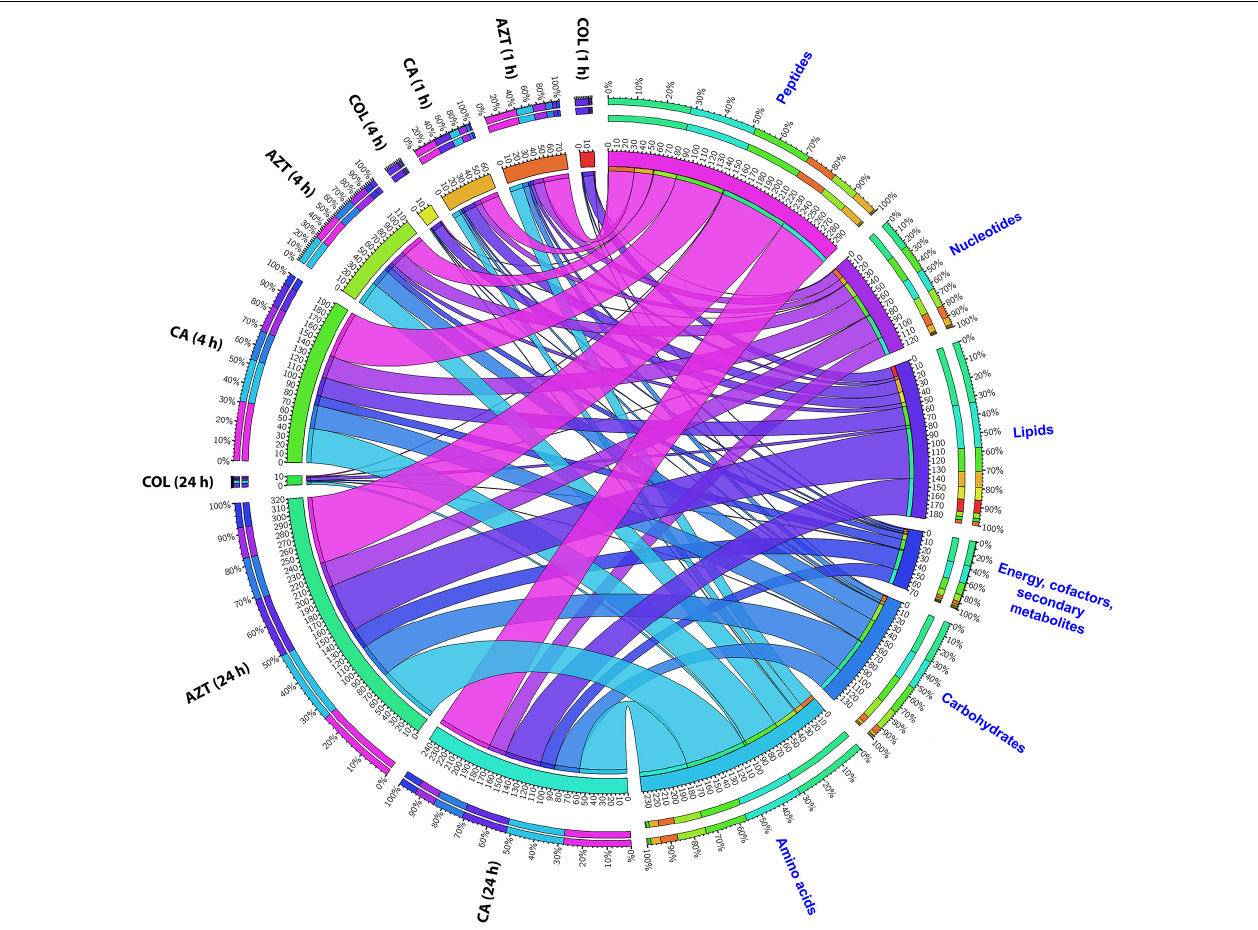
FIGURE 2 | Metabolomic responses of A. baumannii AB090342 after the treatment with colistin (COL), aztreonam (AZT) and the combination (CA) at 1, 4, and 24 h. Bipartite graph shows the correlations of the total number and percentage of significantly affected metabolites (FDR < 0.05, p < 0.05 and FC > 2) in different major classes and all conditions (treatments and time